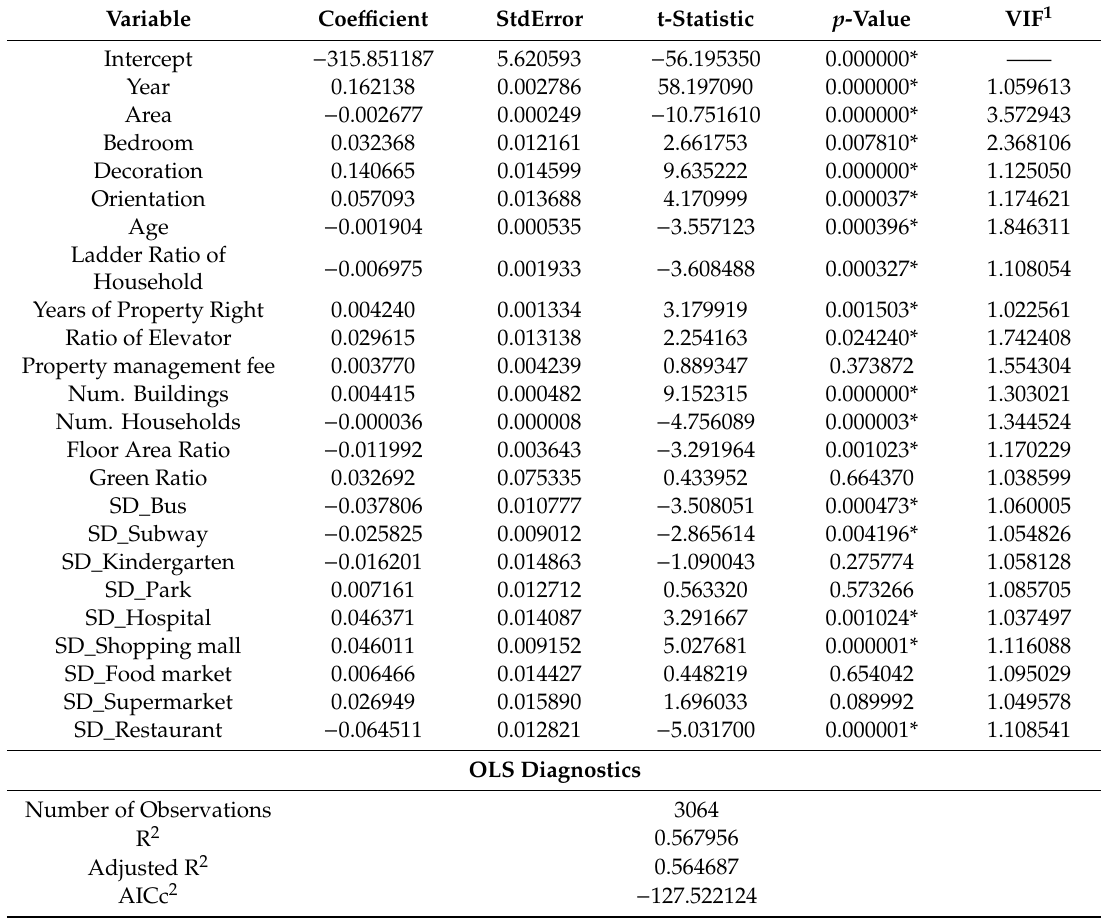
Table 3. Results of the multiple regression analysis (MRA) with ordinary least squares